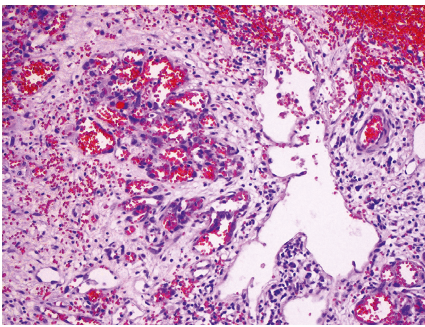
Figure 4: Vascular capillaries of various sizes and cavernous-like spaces lined by endothelial cells with high-grade atypia (hema- toxylin and eosin staining, 200x).